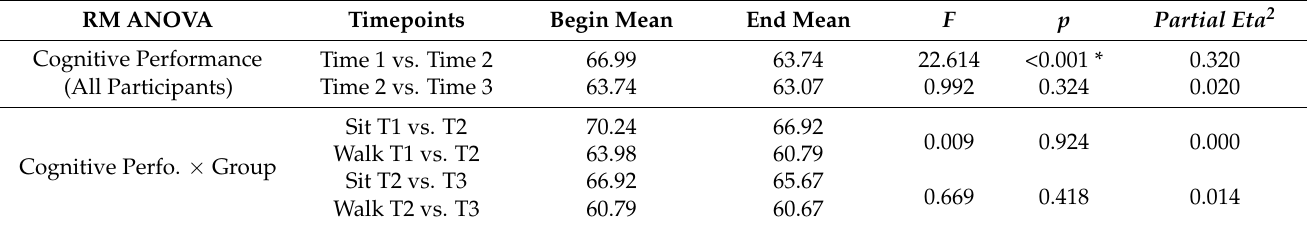
Table 1. RM ANOVA results for cognitive test scores over three time points.